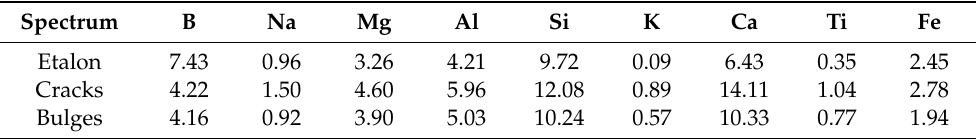
Figure 8. SEM-EDX spectra of the surface of mineral wool fabricated from basalt fibers with two characteristic defects: ( a ) cracks and ( b ) bulges. Fibrous samples with cracks and bulges on the surface showed an increase in the relative amount of Na, Mg, Al, Ca, and K (potassium) elements compared to Si (Table 3). This was similar to the findings of Lund and Yue [4], who measured relative amounts of elements compared to Si in a basalt surface which had been immersed in deionized water at 70 °C for several weeks. Since aged samples showed a relative increase of Al and Ca elements, we might assume that Al 2 O 3 and CaO deposits were formed on the surface. A higher level of CaO in the aged samples suggests that basalt corrosion was in progress [21].